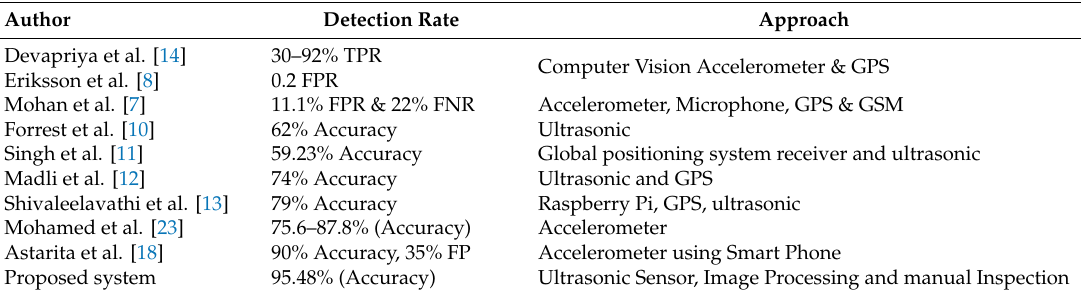
Table 15. Detection rate comparison of di ff erent approaches on previous